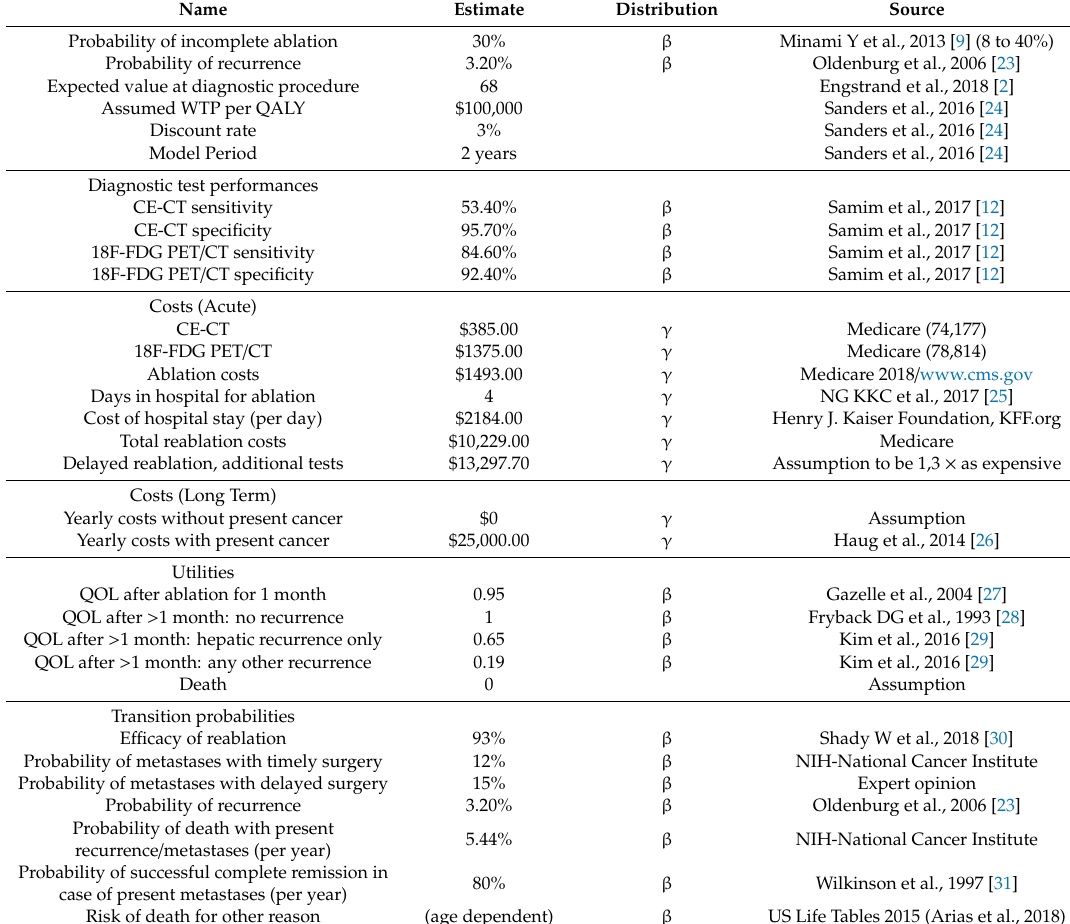
Figure 3. Probabilistic sensitivity analysis utilizing Monte-Carlo simulations with 30,000 iterations. ( a ). Incremental cost-effectiveness scatterplot (18F-FDG PET-CT vs. CE-CT). ( b ). Cost-effectiveness acceptability curve dependent on willingness-to-pay (WTP). 18F-FDG PET-CT is cost-effective in the majority of iterations above a WTP-threshold of $45,000. Table 1. Model input parameters.